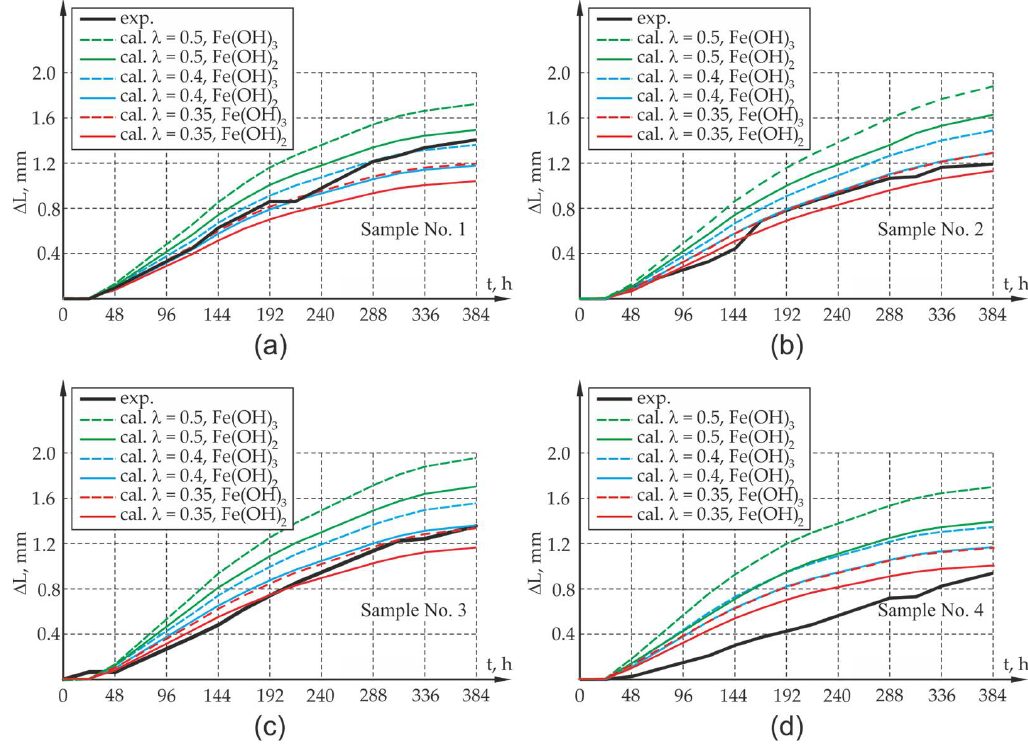
Figure 10. Average elongation values of edges ∆ L A1A2 and ∆ L B1B2 of the reinforced concrete sample together with calculation results for the 50%, 60% and 65% reductions of the impact intensity of corrosion products ( λ = 0.5, λ = 0.4, λ = 0.35): ( a ) sample P1, ( b ) sample P2, ( c ) sample P3, ( d ) sample P4.